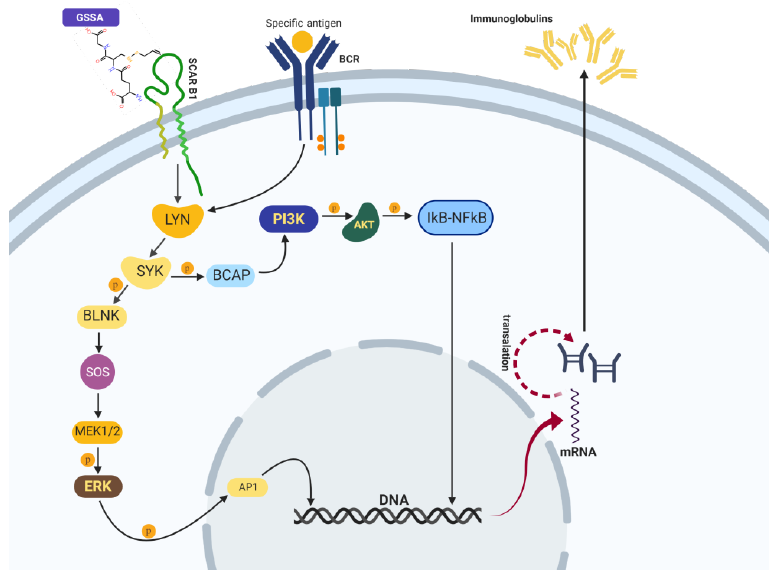
Figure 8. Signaling pathway for GSSA via SCARB1 receptor from CD19+ lymphocyte. According to